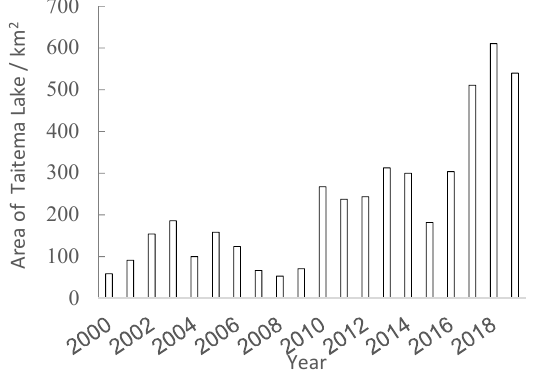
Figure 4. Variation in the area of Taitema Lake.